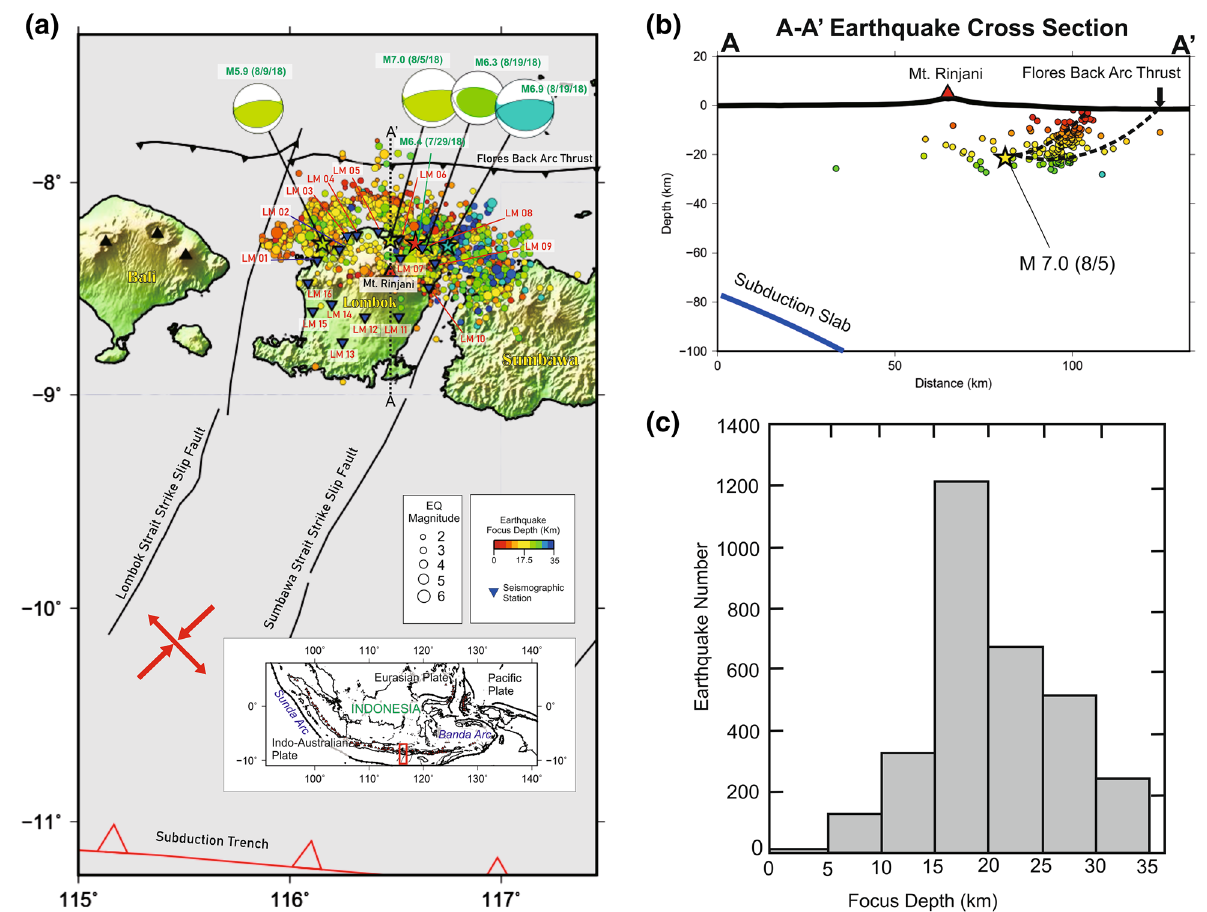
Fig. 1 a The location of the study area (red box on the inset map), overlaid with the 2018 Lombok earthquake aftershock hypocenter (circle), modified from Sasmi et al. (2020). The red arrows show compressional strain rate direction from Bock et al. (2003). The colored star symbol shows the hypocentres of significant earthquake. The dashed black line in Fig. 1a represents A-A’ hypocentre cross section illustrated in 1b) (Sasmi et al. 2020). The black triangle shows the location of volcanoes. The red triangle depicts Mt. Rinjani. The focal mechanism of the significant earthquake was taken from Global Centroid Moment Tensor (Ekström et al. 2012); b aftershock cross section of A-A’ line in Fig. 1a, the width of the window used in cross Sect. 1b is 10 km. The curved dashed line represents the interpretation of the 2018 Lombok earthquake fault from Sasmi et al. (2020). The star symbol depicts the hypocenter of the August 7 (M w 6.9) earthquake; c histogram of the number of earthquake per